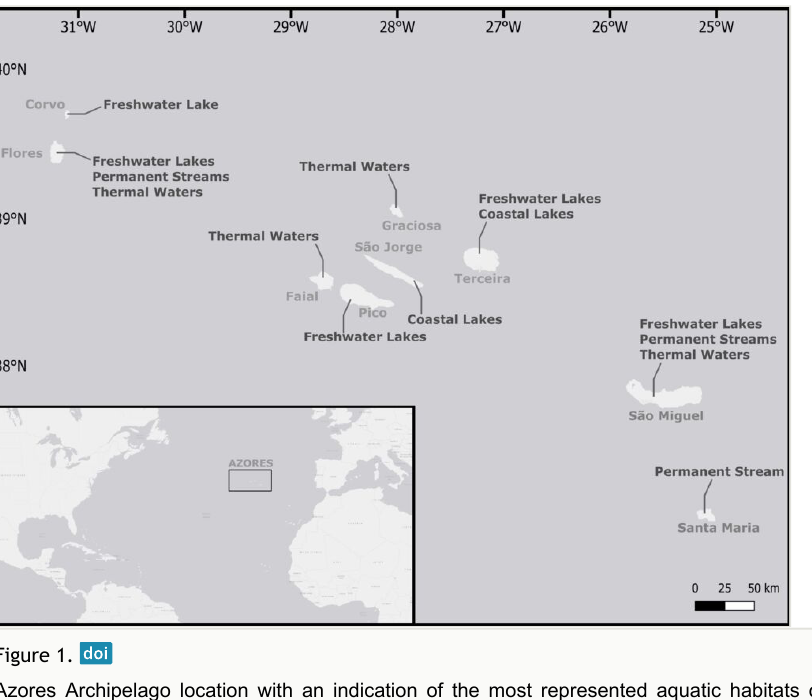
Azores Archipelago location with an indication of the most represented aquatic habitats on each